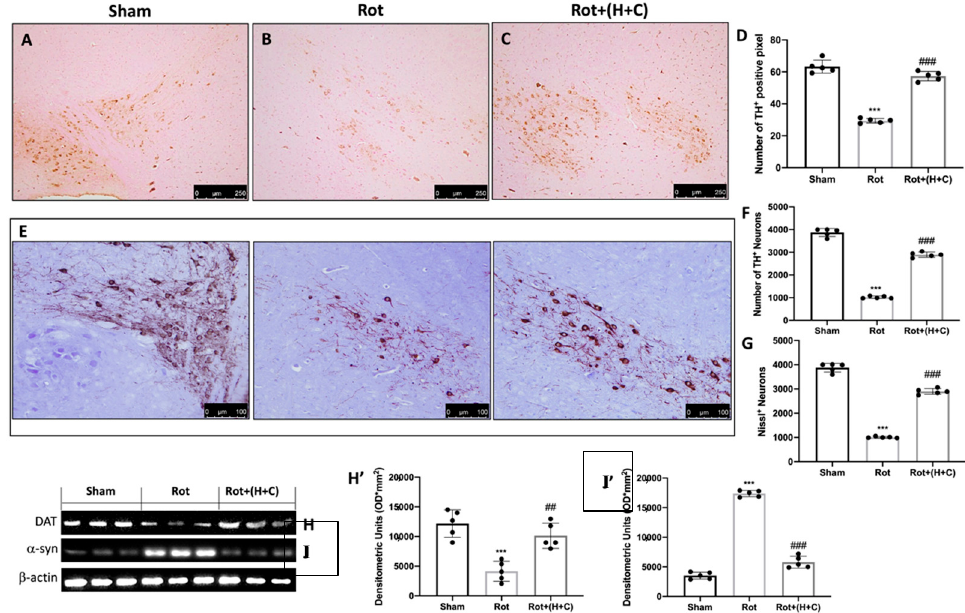
Figure 5. Effects of H+C on TH, DAT and α -syn expression in Rot-treated mice. The immunohisto- chemical analysis has shown, compared with the Sham mice ( A ), a noticeable loss of TH-positive cells in mice of the Rot group ( B ). Animals treated with H+C revealed an increase in TH expression ( C ). Data are expressed as % of TH-positive pixels and are the SD means of n = 5 mice/group ( D ). *** p < 0.001 compared to Sham; ### p < 0.001 compared to Rot. Stereological counting of TH+ and cresyl-violet-positive neurons in substantia nigra slices from one hemisphere ( F,G ). Images of TH immunohistochemistry in midbrain slices counterstained with cresyl violet ( E ). Each data point is expressed as the number of TH+ and Nissl+ neurons and is the mean SD from n = 5 mice per group. *** p < 0.001 when compared to Sham; ### p < 0.001 when compared to Rot. Western blot analysis revealed, compared with Sham group, an evident decrease in DAT in Rot-treated mice. Animals subjected to treatment with H+C revealed a significant rise in DAT ( H ). See densitometric graph ( H’ ). In addition, this analysis revealed a significant increase in α -syn in the Rot group compared to Sham animals. The H+C treatment significantly reduced the increase in this protein ( I ). See densitometric graph ( I’ ). The data are representative of at least three independent experiments and are expressed as the mean ± SD of n = 5 mice for each group. ( I ) *** p < 0.001 compared to Sham; ## p < 0.01 compared to Rot; ### p < 0.001 compared to